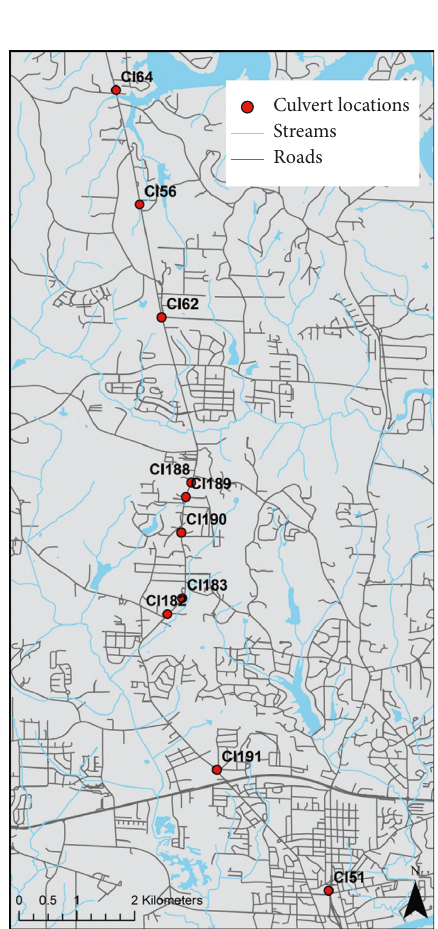
Figure 6: Map of study area including roadways, streams, and existing culvert